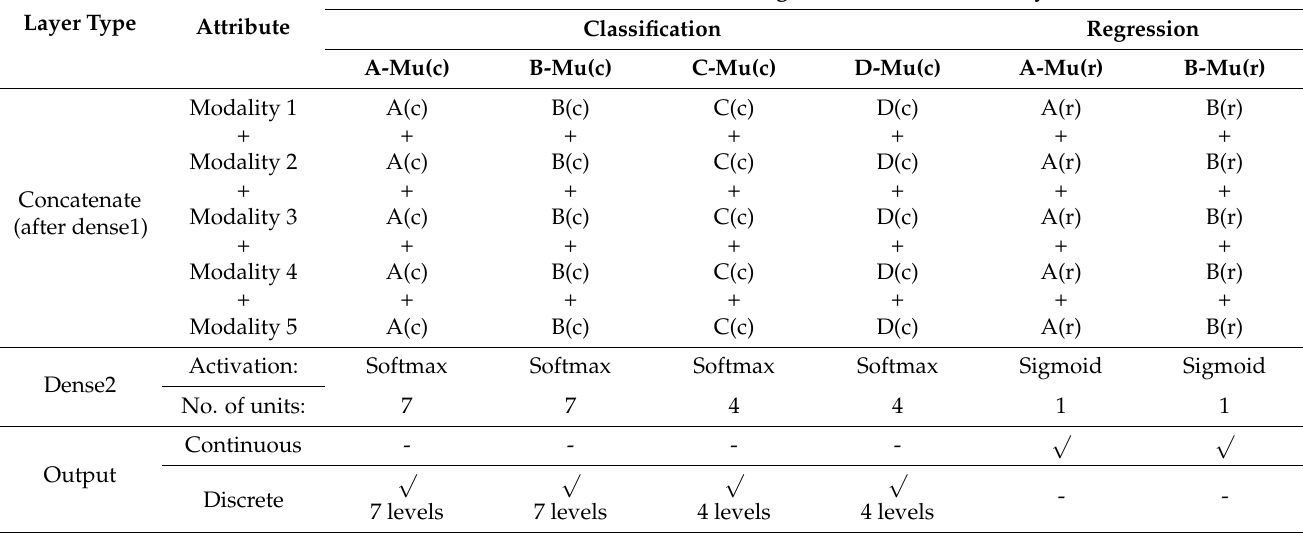
Table 5. A summary of the LSTM/LSTM-SW architectures’ configurations using